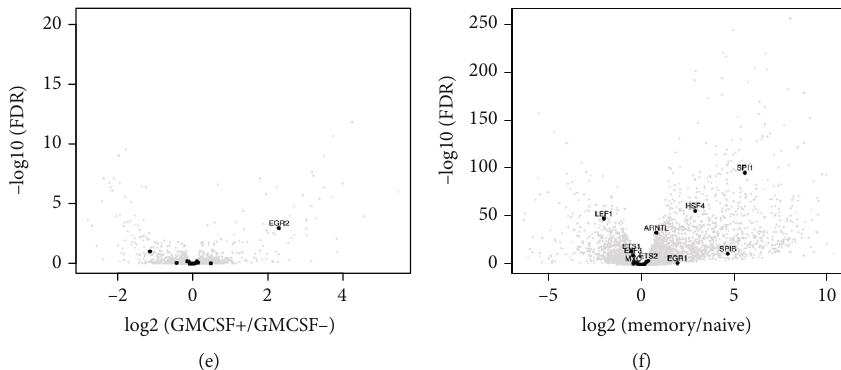
Figure 7: Identi fi cation of key TFs with global regulatory e ff ect. (a, b) Rank-based enrichment analysis of TF binding motifs in footprints ð FDR Þ × sign ð log ð foldchange ÞÞ function. The analysis within peaks that were ranked based on di ff erential accessibility using the – log 10 2 was performed separately for the GM-CSF+/GM-CSF − and memory/naïve cell comparison ((a) and (b), respectively). NES: normalized enrichment score. (c, d) Average expression levels of identi fi ed key TFs for both cell comparisons are shown as log ð countper million reads Þ . To indicate the relative expression level of these TFs (bars) in view of the spectrum of lowly and highly expressed genes, the scaled kernel density estimate is shown based on the distribution of the average expression of all genes. (e, f) Volcano plots show the di ff erential expression (e ff ect size vs. signi fi cance) of the TFs identi fi ed as key regulators in each of the cell type comparisons (GM-CSF+/GM-CSF − and memory/naïve cell comparison; (e) and (f)). Key TFs are indicated as black dots, and those which are DEGs are labeled with their gene